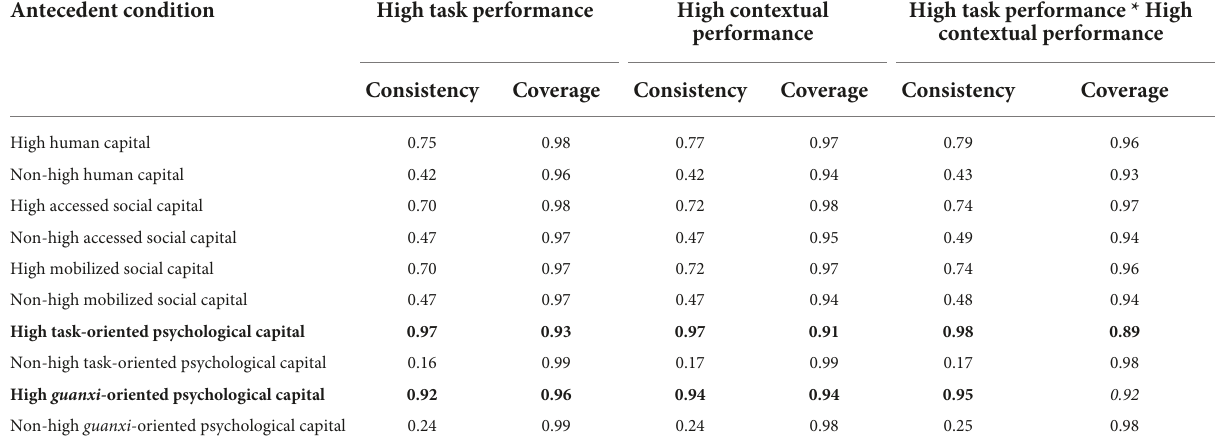
TABLE 2 Necessity analysis of antecedent conditions for job performance.